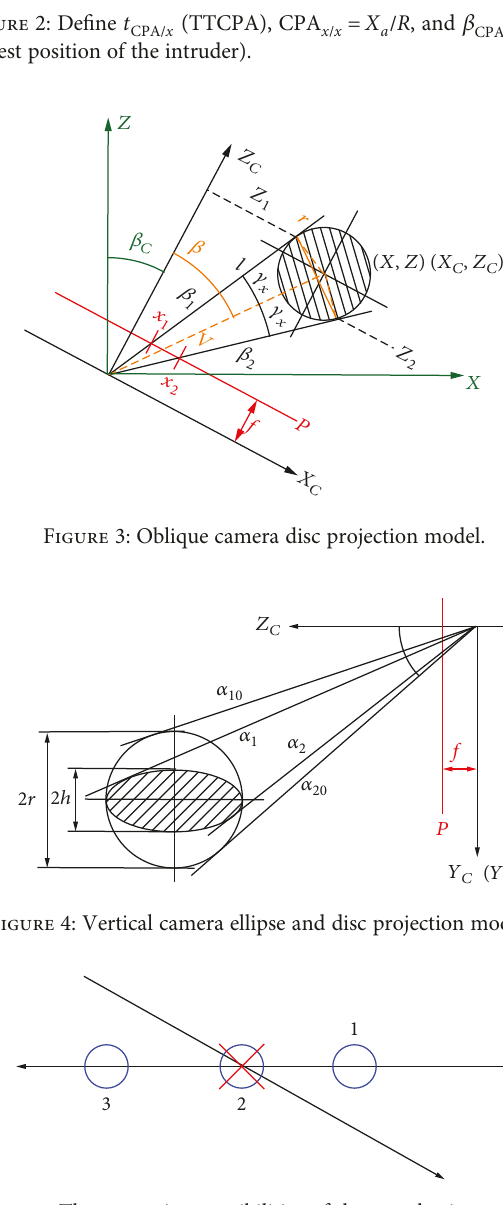
(TTCPA), CPA x = X a / R , and β (intruder: red on the left, own A/C: blue on the right, and P CPA/ x / x CPA/ x